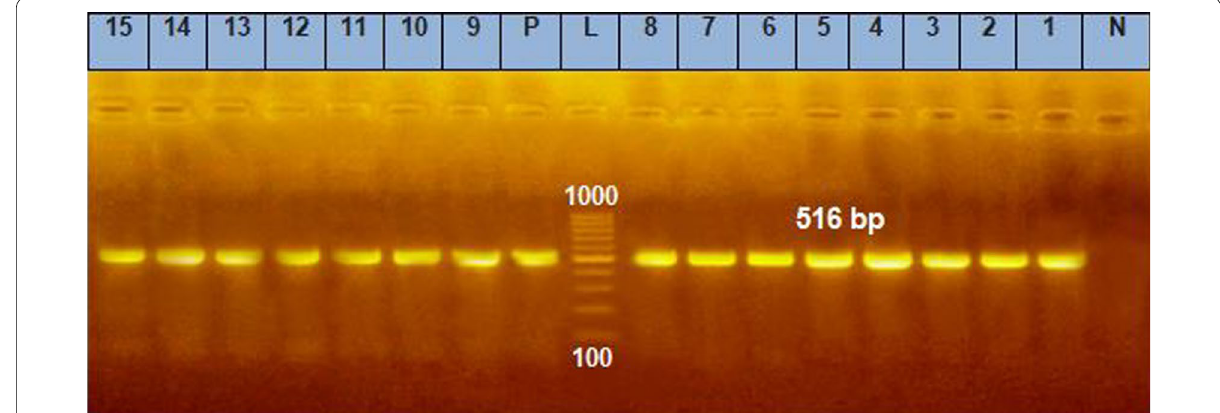
Fig. 5 Agarose gel electrophoresis showing amplification product of 516 bp of TEM . Lane L : Ladder (Marker) 100‑1000 bp plus DNA ladder. Lane P : control positive. Lane N : control negative. Lane 1–15 : examined isolates